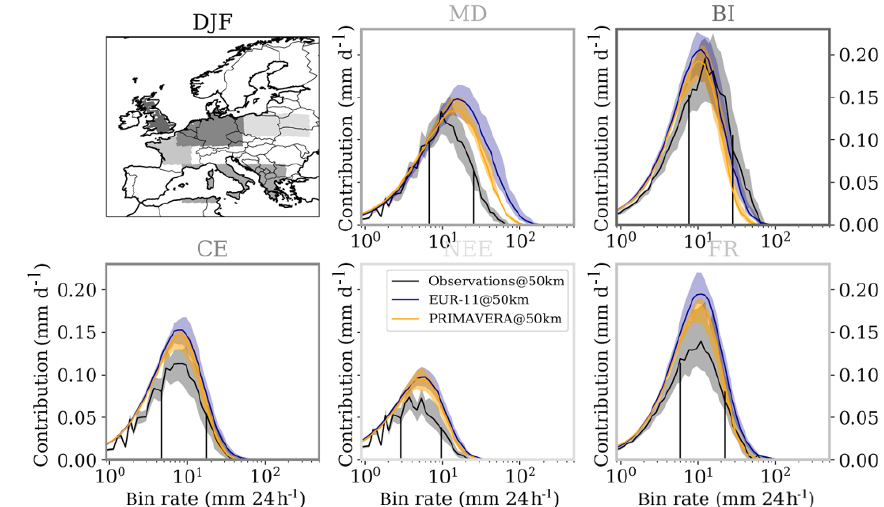
Figure 6. Precipitation contribution (frequency × bin rate) per precipitation rate in DJF over the Mediterranean (MD), the British Isles (BI), central Europe (CE), northeast Europe (NEE), and France (FR) for EUR-11 (blue), PRIMAVERA (orange), and observations (black) regridded on EUR-44.